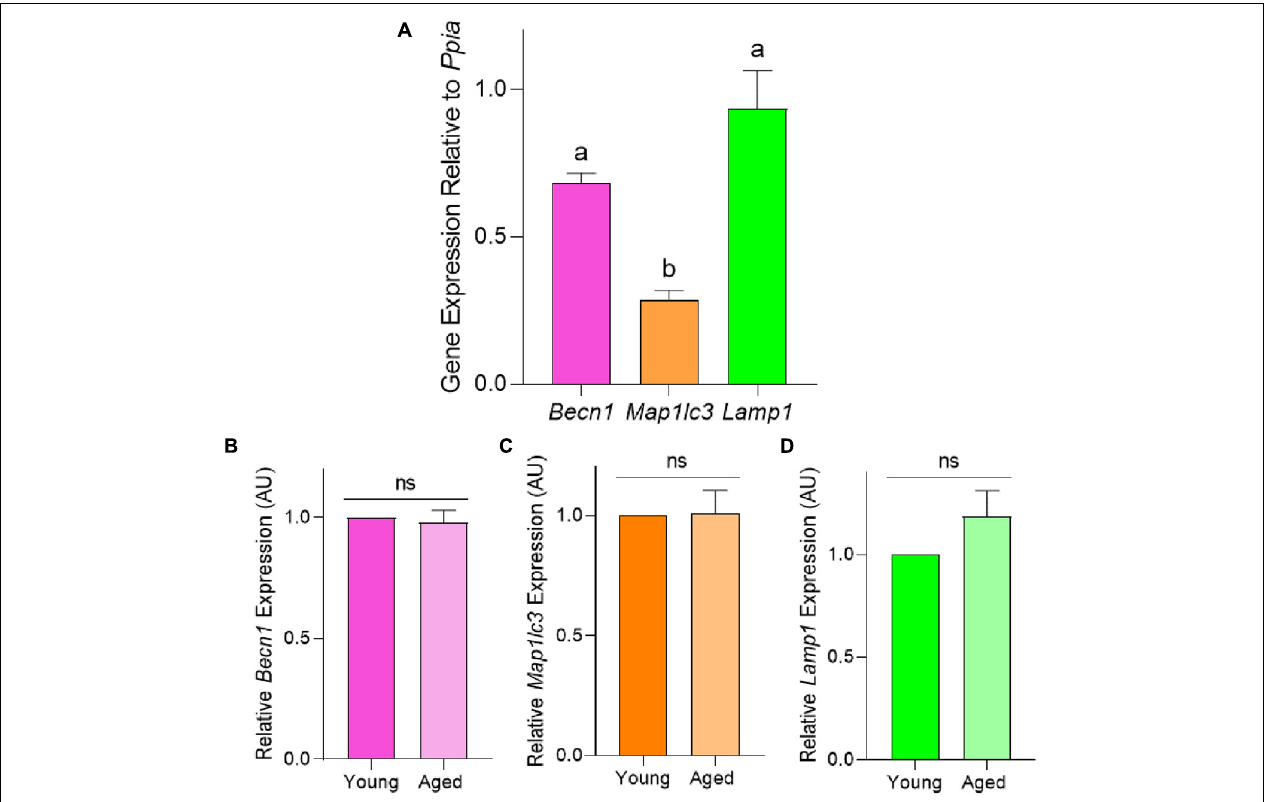
FIGURE 3 | Relative mRNA expression of autophagy pathway members Becn1 , Map1lc3 , and Lamp1 in the pre-ovulatory oocytes of young and aged mice. RT-qPCR was performed on oocytes collected from young (4–6 weeks old) and aged (12–14 months old) mice to assess the target gene expression relative to Ppia , the steady state housekeeping gene. (A) Comparison of Becn1 , Map1lc3 , and Lamp1 expression in young oocytes. Comparison of relative (B) Becn1 , (C) Map1lc3 , and (D) Lamp1 gene expression in populations of young and aged mouse oocytes (normalized to young). All data are presented as mean ± SEM ( n = 4), with statistical significance ( P < 0.05) between target gene expression in panel (A) denoted by different letters; ns, not